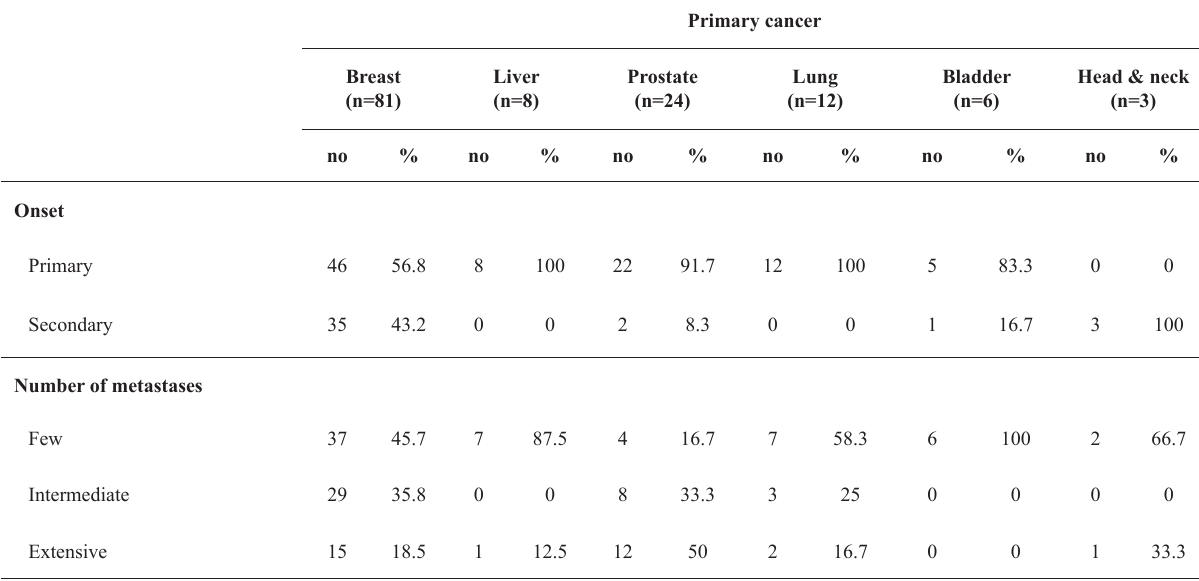
Table 2: The onset and number of bone metastases in different cancer types.